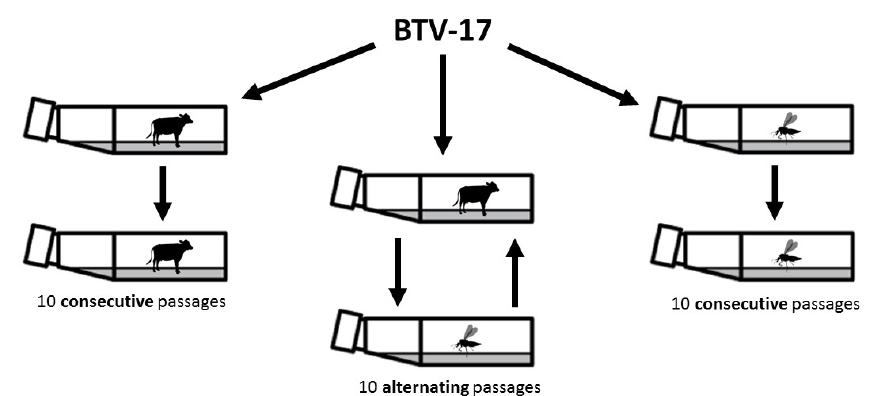
Figure 1. Experimental Set-up. A field isolate of bluetongue virus (BTV)-17 (BTV17-INPUT) was passaged under three different cell culture conditions: serial passages in bovine cells (BTV17-BPAEC); serial passages in Culicoides sonorensis cells (BTV17-CUVA); and alternating passages in bovine and C. sonorensis cells (BTV17-ALT) for 10 consecutive passages.